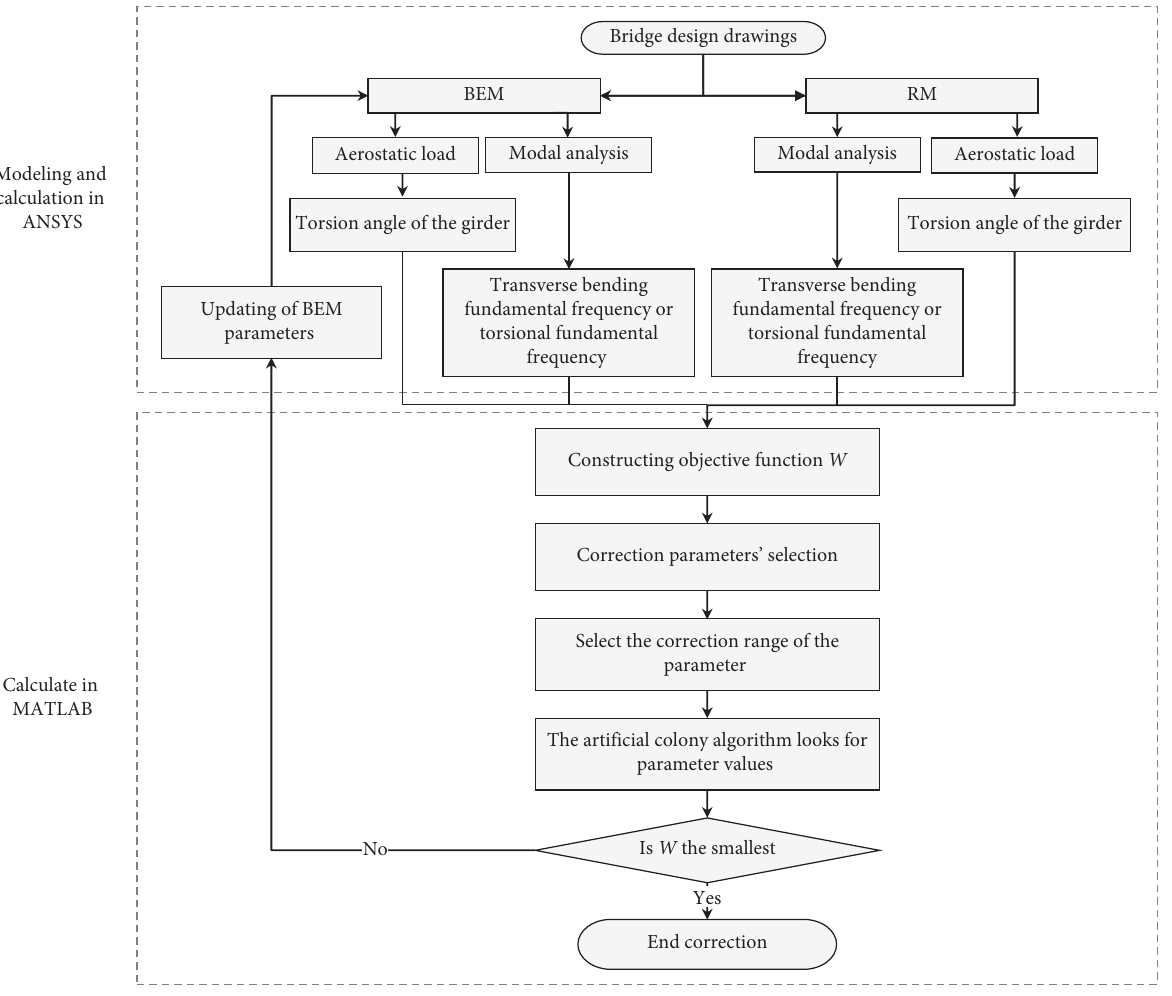
Figure 7: Model correction